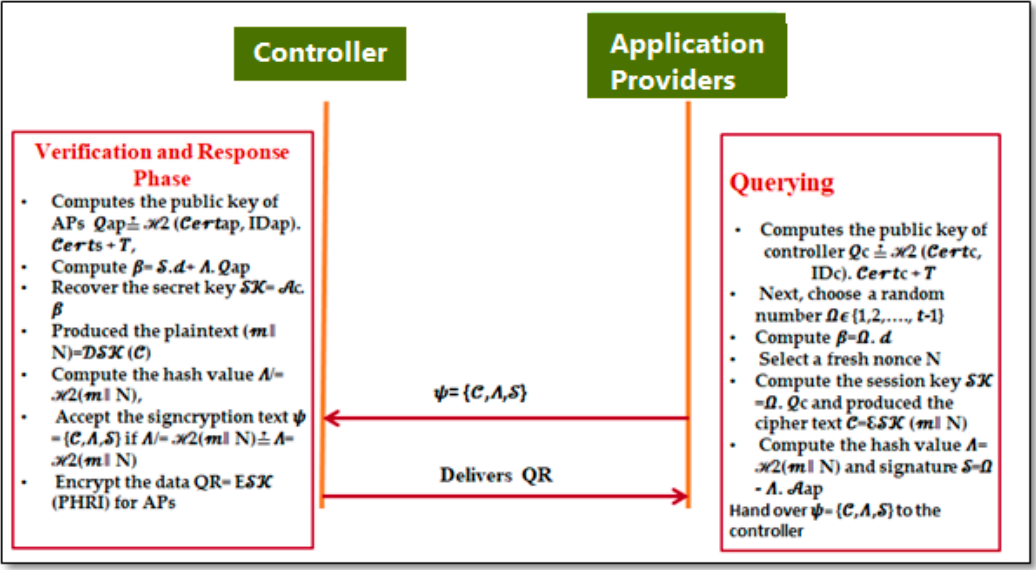
Figure 3. Querying and response phase of CB-SN access control for WBAN.